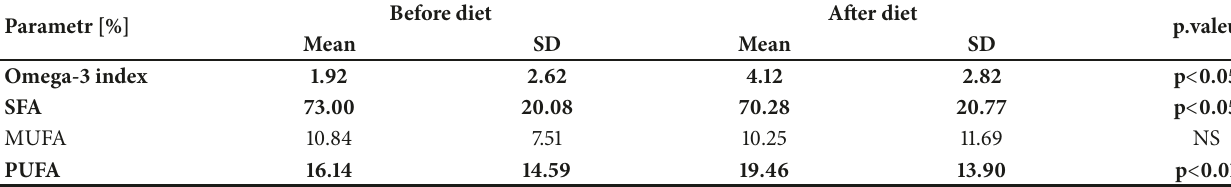
Table 5: The differences in the content of particular fatty acid groups and in the indexes of fatty acids. Before diet After Parametr [%]